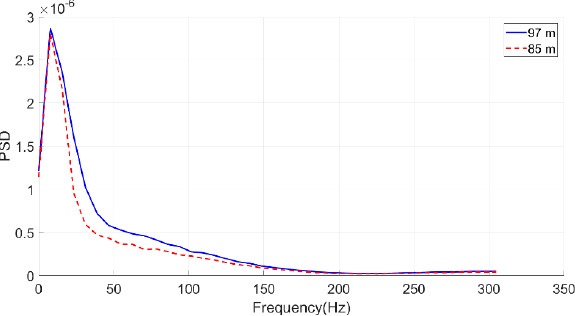
Figure 21. Average power spectral density (PSD) at 97 m and 85 m.